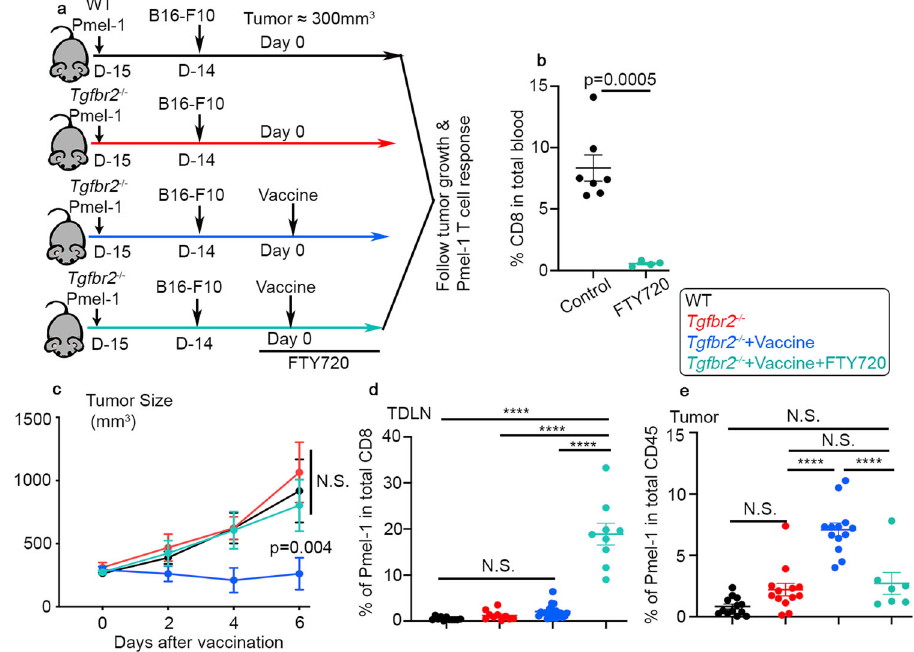
Fig.3|Cellmigrationisrequiredfor Tgfbr2 − / − Pmel-1Tcellstorespondtotumor vaccine. a Experimental design. Black, WT-vaccine; red, Tgfbr2 − / − -vaccine; blue, Tgfbr2 − / − +vaccine; and aqua, Tgfbr2 − / − +vaccine+FTY720. b The percentage of CD8 + T cells in red blood cell lysed total peripheral blood are shown (control, n =7 and FTY720, n =4). c Tumor size ( n =4 for WT group and n =5 for Tgfbr2 − / − groups). Statistical analysis was performed on day 6 results. d The percentage of donor Pmel-1TcellsintotalCD8 + TcellsisolatedfromTDLNisshown(WT, n =11, Tgfbr2 − / − , n =10, Tgfbr2 − / − +Vaccine, n =21, and Tgfbr2 − / − +Vaccine+FTY720, n =9). e The